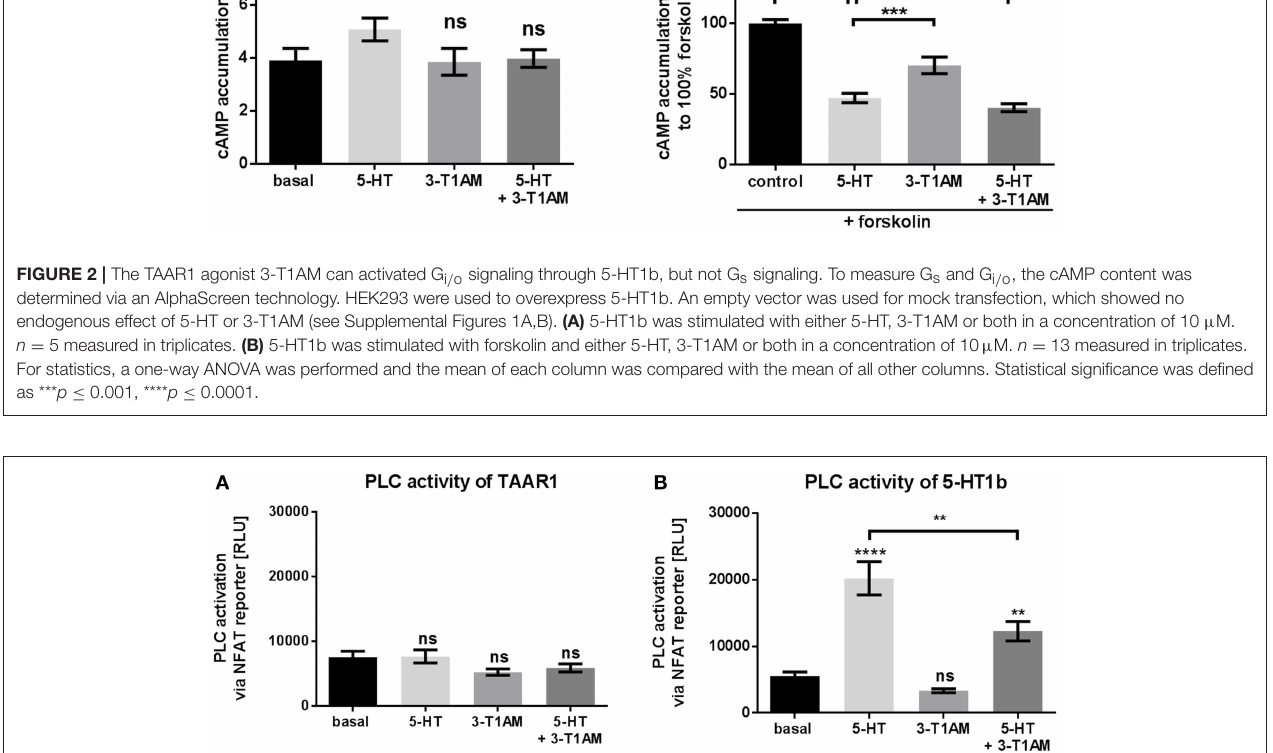
FIGURE 3 | 3-T1AM is not able to activate PLC via TAAR1 or 5-HT1b. Activation of PLC was measured by NFAT reporter gene assay. HEK293 were used to overexpress TAAR1 or 5-HT1b. An empty vector was used for mock transfection, which showed no endogenous effect of 5-HT or 3-T1AM (Supplemental